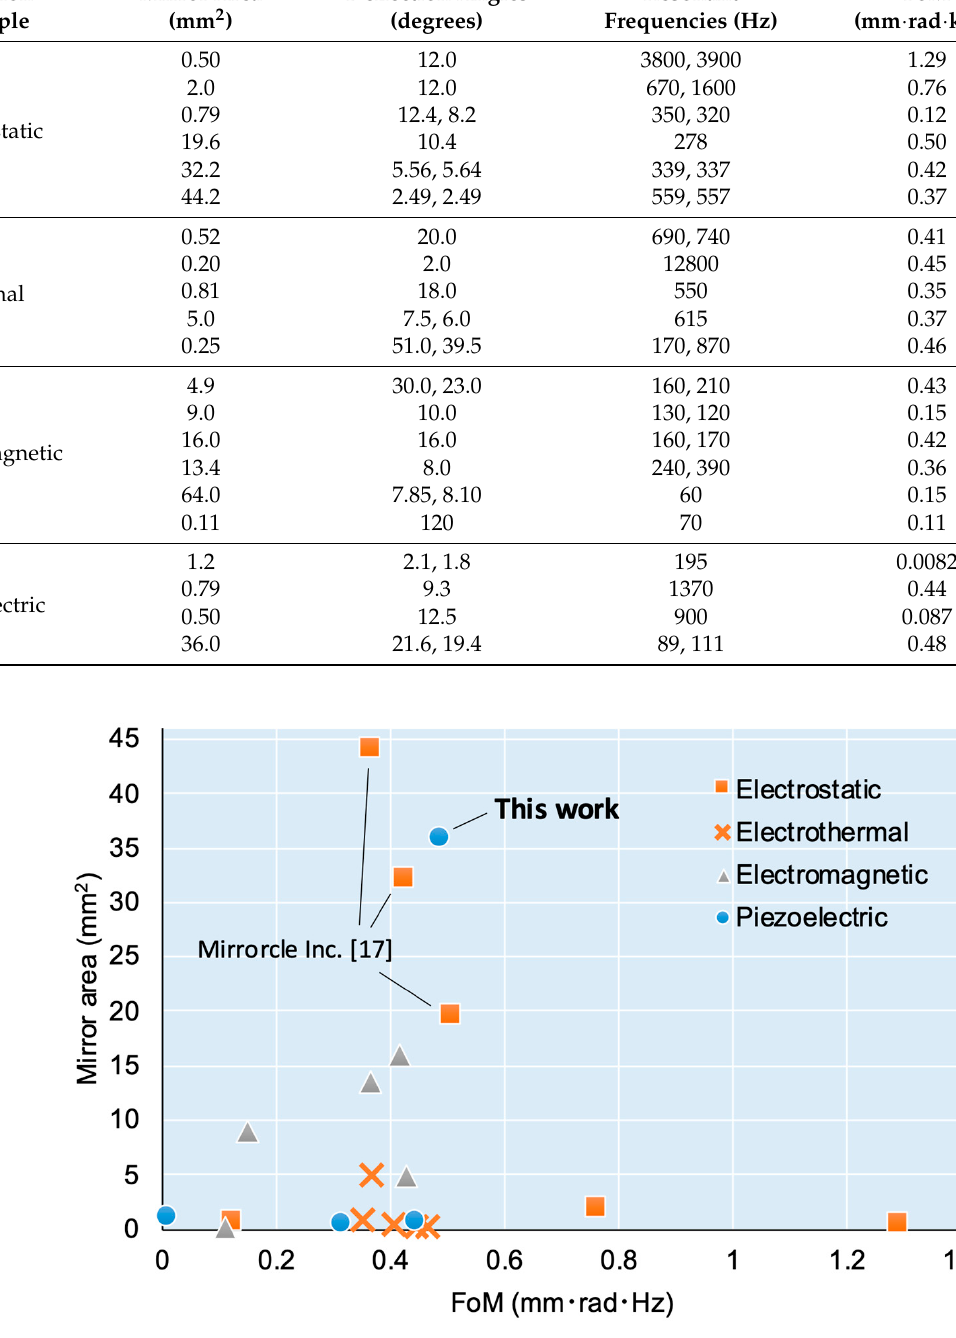
Figure 13. Comparison of 2-DoF quasi-static scanners.